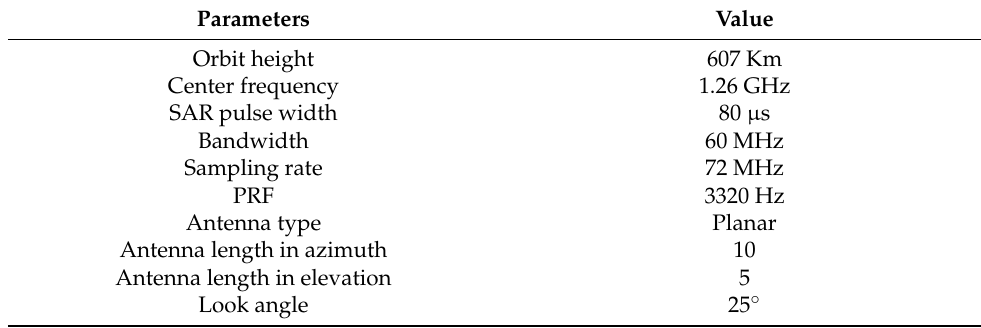
Table 1. Spaceborne SAR simulation